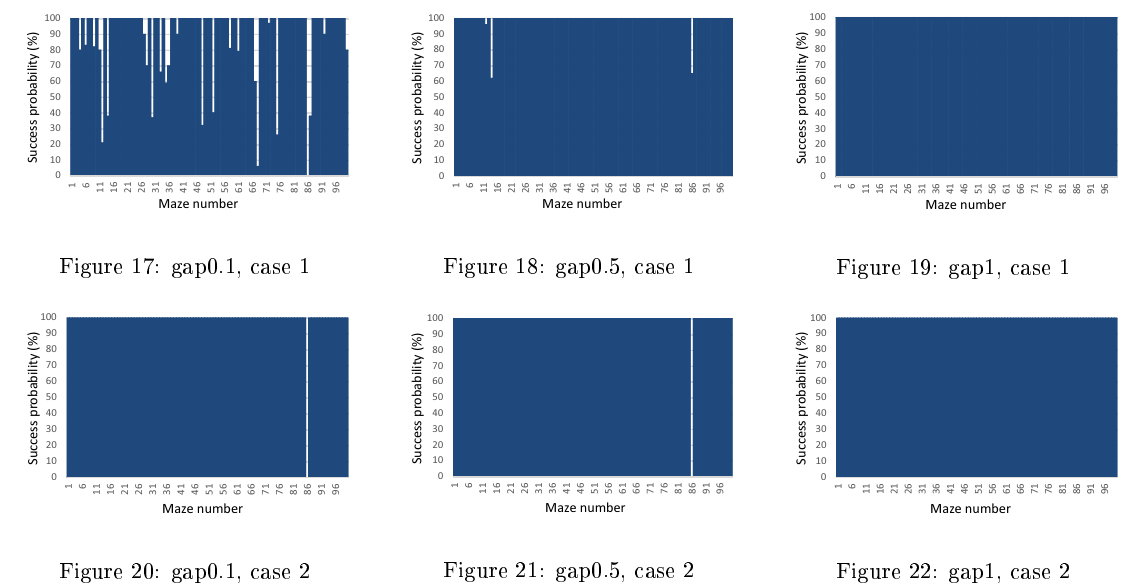
Figure 21: gap0.5, case 2 Figure 22: gap1, case 2 Figure 23: Result of reward di(cid:27)erence for proposed method(Q-learning)